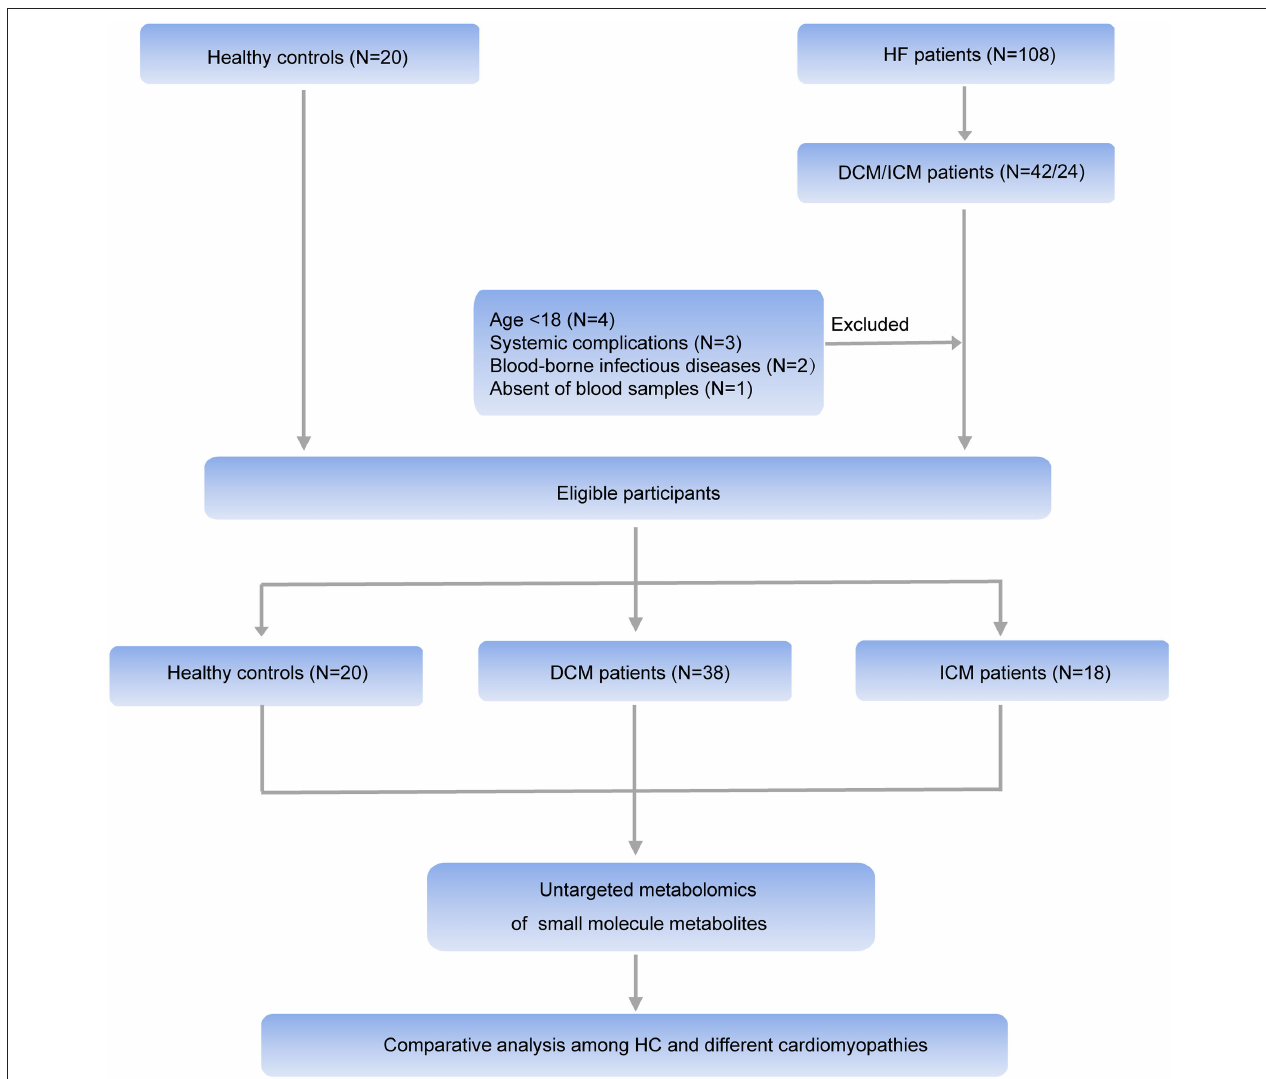
FIGURE 1 | Workflow of the present study. In general, HF patients with different etiology (38 patients with DCM and 18 patients with ICM, respectively), and 20 healthy controls were enrolled in this study. An untargeted metabolomic panel was applied to the plasma samples of these individuals. We comparatively analyzed the plasma metabolomics profiling of the 3 groups to clarify the differences in HF patients with different etiology from the perspective of circulation